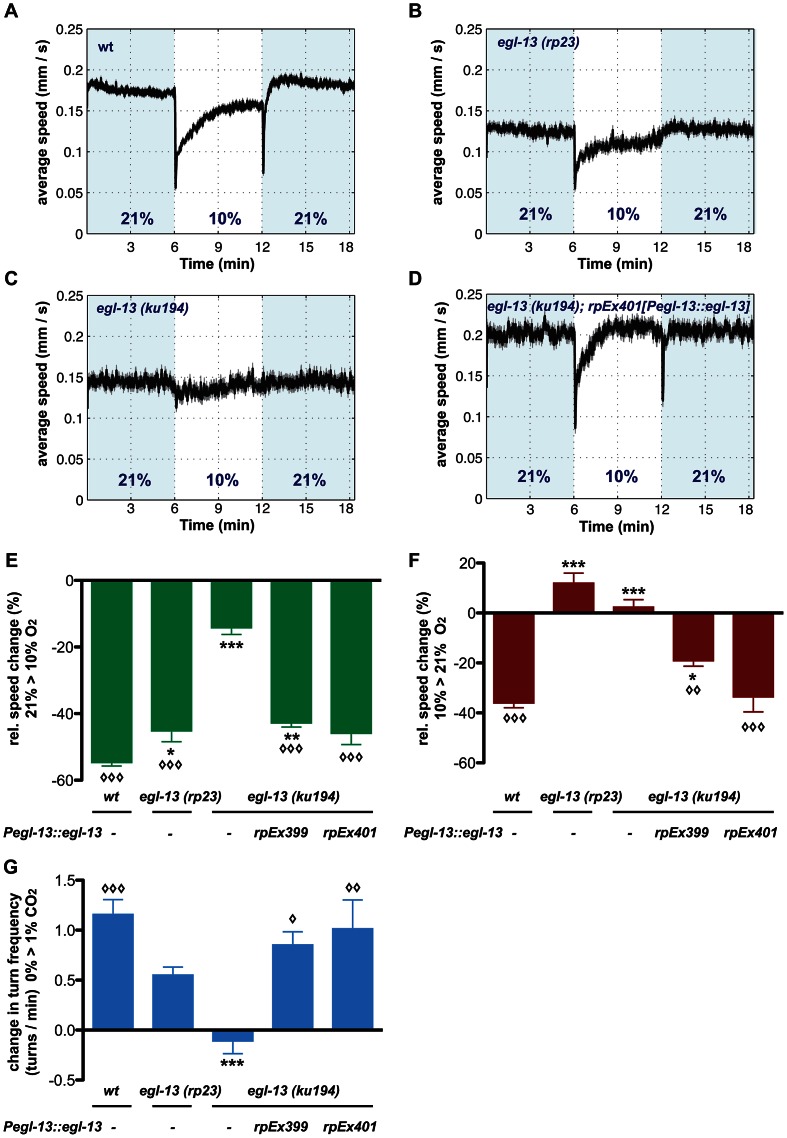

egl-13 is essential for locomotion responses to O2 and CO2 concentration shifts.(A-D) Locomotion speed of C. elegans during O2 concentration shifts. Traces show average forward speed and dark shading indicates standard error of the mean (SEM). O2 concentrations were switched between 21% and 10%. Shading represents intervals at 21%. (A) Wild-type animals. (B) egl-13(rp23) mutants. (C) egl-13(ku194) mutants. (D) Rescue of egl-13(ku194) mutant phenotype by transgenic expression of egl-13 cDNA under control of its own promoter. Transgene rpEx401. Note the respective reduction of speed levels in N2 after up- and downshift, which are abolished in egl-13(ku194) and restored in the transgenic line. egl-13(rp23) animals are affected mostly in their response to O2 upshift. (E, F) Quantification of data in A–D. Average speed changes in percent from basal speed to O2 downshift (E) and upshift (F) of animals with indicated genotypes. Transgenic rescue lines are significantly different from egl-13(ku194) mutant animals. (G) Average changes in omega turn frequency of animals with indicated genotypes, in response to 1% CO2. The defect in omega turn responses seen in egl-13(ku194) animals is restored in the transgenic lines (rpEx399 and rpEx401). egl-13(rp23) animals only exhibit a partial defect. Error bars = SEM. Symbols indicate all significant differences one-way ANOVA with Bonferroni's Multiple Comparison Test (*/◊ p = 0.01–0.05, **/◊◊ p = 0.001–0.01, ***/◊◊◊ p<0.001). Asterisks indicate significant difference compared to wild-type, while diamonds indicate significant difference compared to egl-13(ku194) mutants. Data were calculated from n = 3 independent experiments for each mutant and transgenic rescue strain, and n = 6 independent experiments for wild-type. Each individual experiment was performed on 60–70 animals.